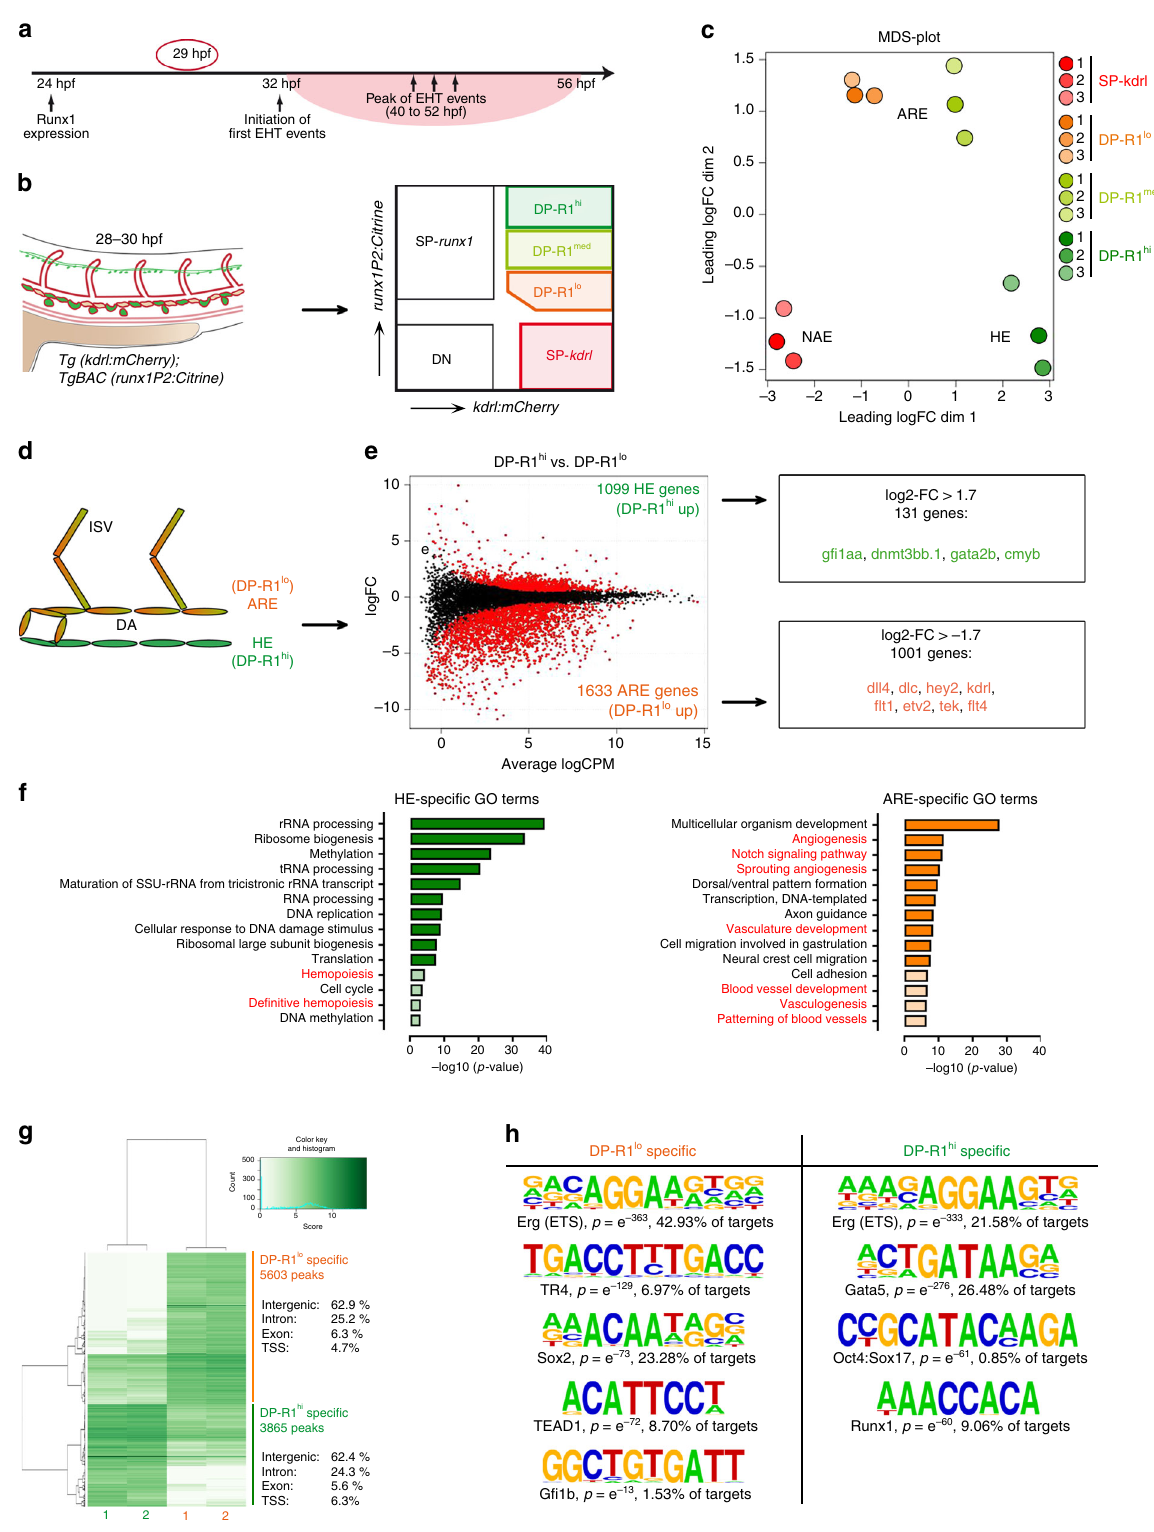
larger genetic programme with DP-R1 lo /DP-R1 med cells (Cluster 2, 1305 genes) than with SP- kdrl cells (Cluster 5, 812 genes). In line with the detected carryover of Citrine protein to the ARE, these genetic commonalities hint at a close lineage relationship between the HE and ARE.